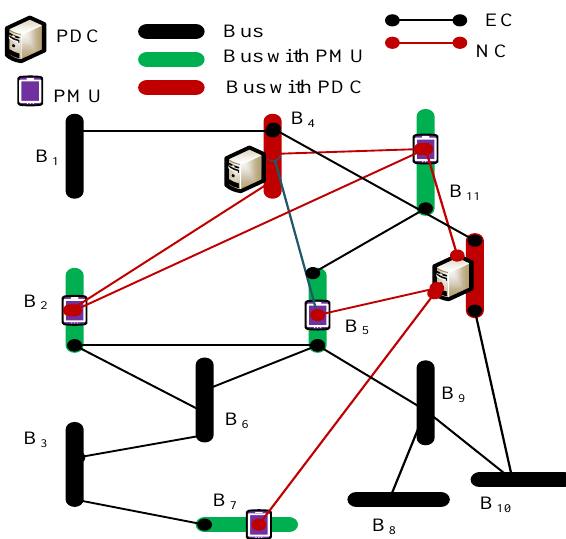
Figure 1. Illustration of an SCN for graph-theoretical modelling.